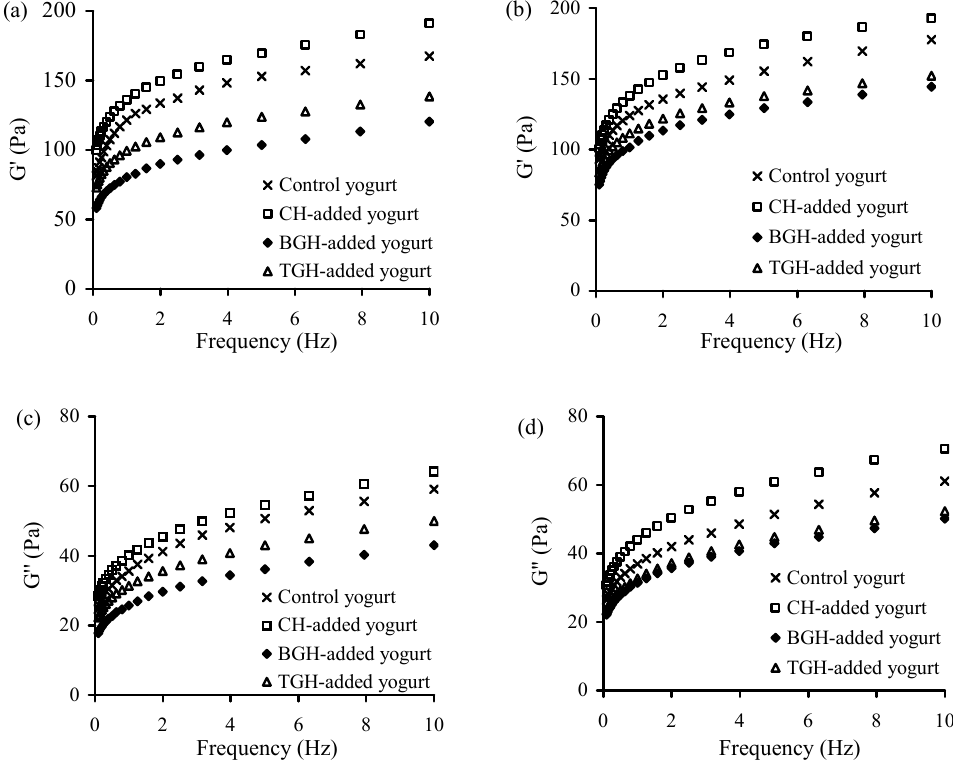
Figure 3. The measured G ′ and G ″ value of the four yogurt samples stored at 4 ° C for 1 ( a , c ), or 21 days ( b , d ).